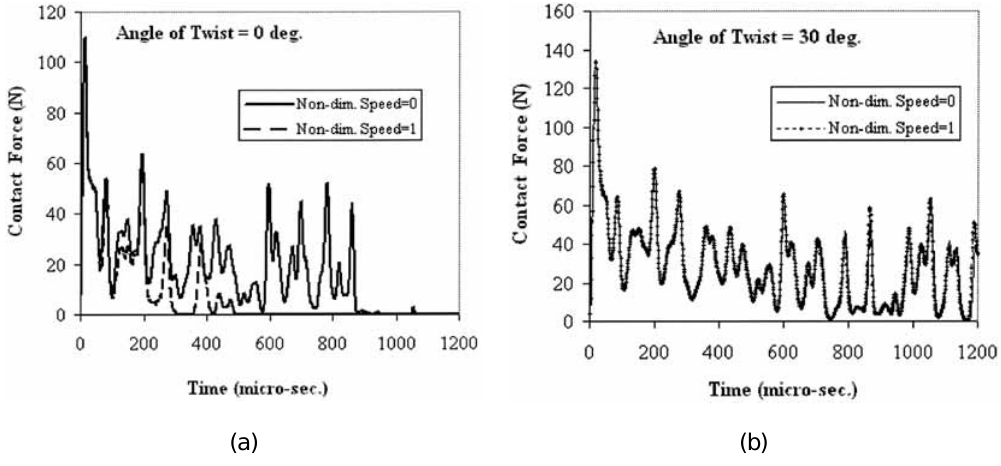
Fig. 4. (a) The effect of rotational speed on contact force for bending stiff ([0 2 / ± 30] S ) graphite-epoxy composite cantilever cylindrical shell with 25% mid-plane delamination (relative position of centre line at 0.25 from the fixed end). (b) The effect of rotational speed on contact force